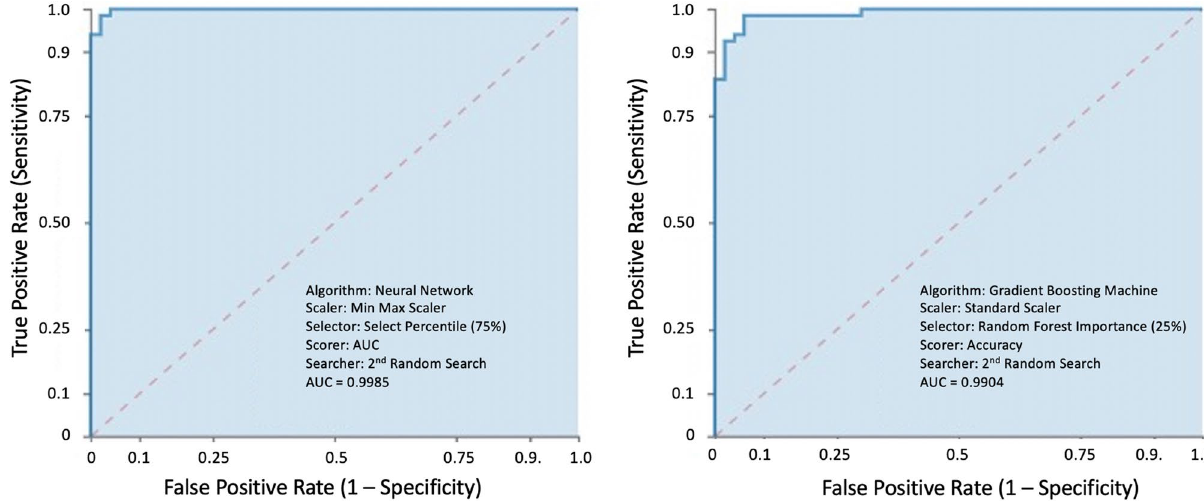
Figure 5. Receiver operator characteristic curves of the top performing ML models. The figure illustrates optimized deep neural network ( A ) and gradient boosting machine ( B ) ML models secondarily tested by Dataset B. For the deep neural network, the ML model used 75% of MS peaks (features) to yield a positive percent agreement of 100% (95% CI 95–100%), and negative percent agreement of 96% (95% CI 86–99%), with an area under the receiver operator curve of 0.9985. In contrast, the Gradient Boosting Machine ML model used only 25% of the MS peaks (features) to yield a positive percent agreement of 99% (95% CI 92–100%) and negative percent agreement of 94% (95% CI 84–99%) with an area under the receiver operator curve of